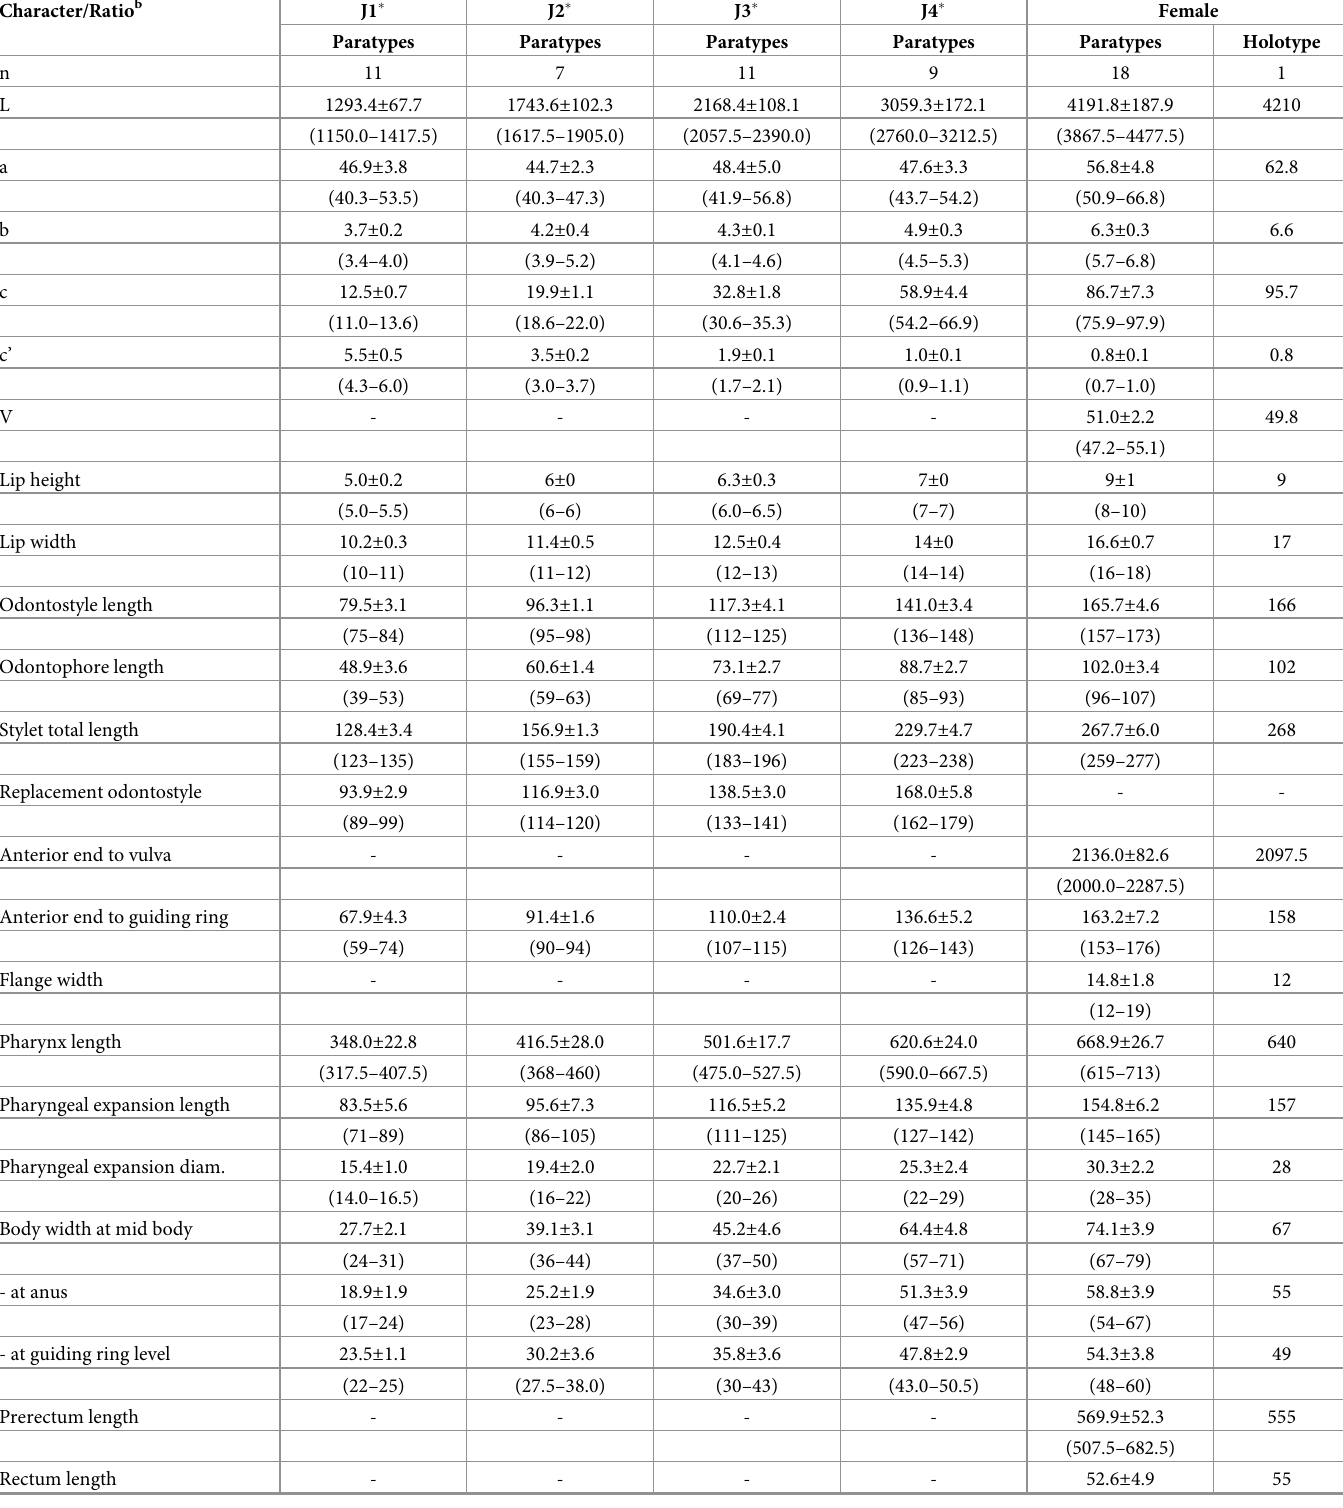
Table 1. Morphometrics of the type population of Xiphinema afratakhtehnsis sp. nov. (population code 801) a